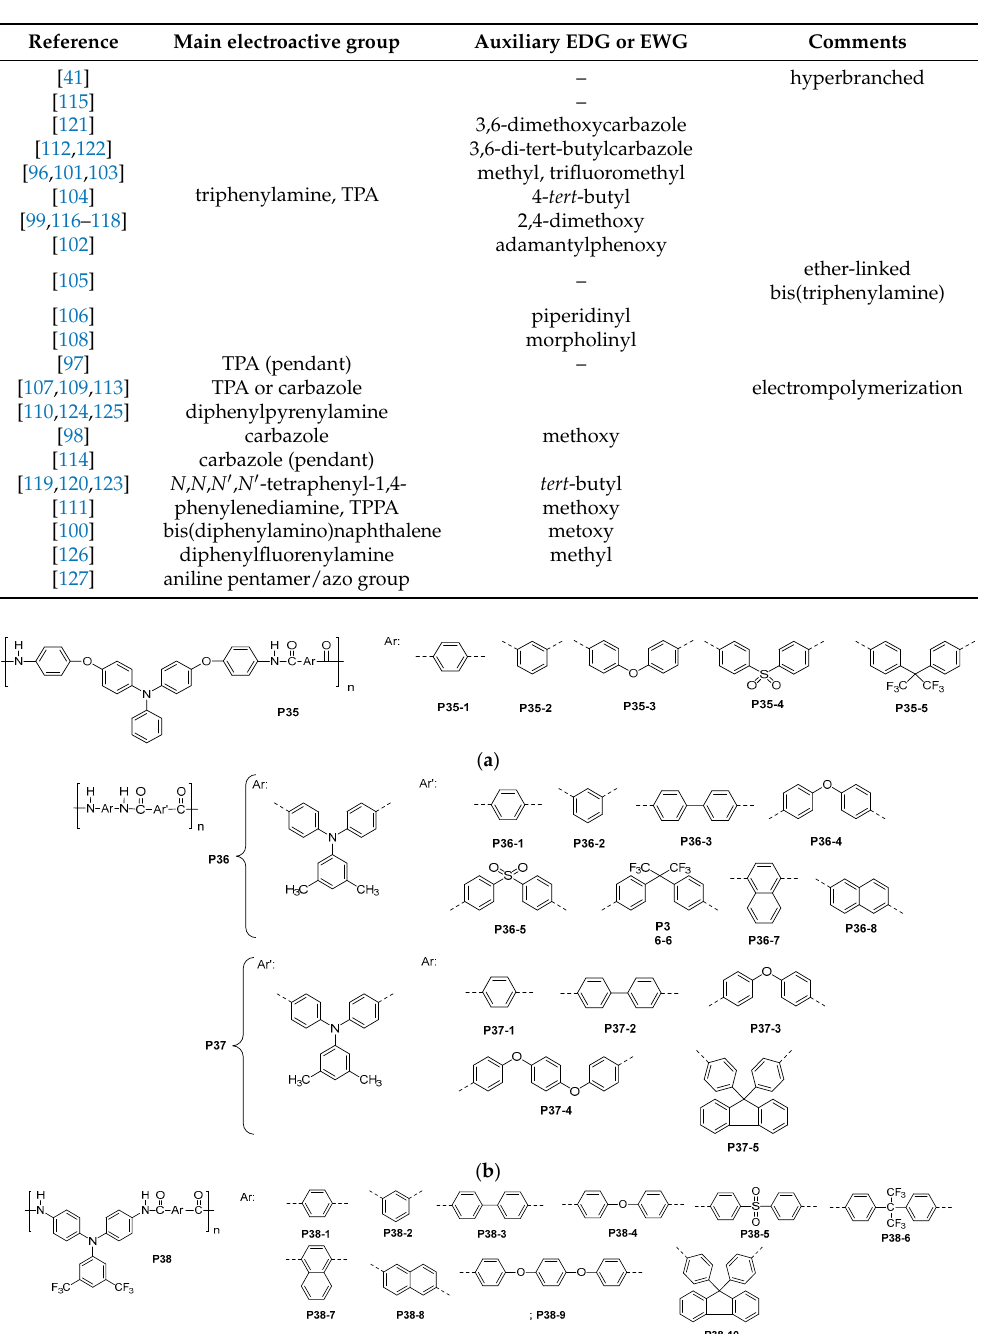
Table 3. Summary electroactive sub-groups in electrochromic